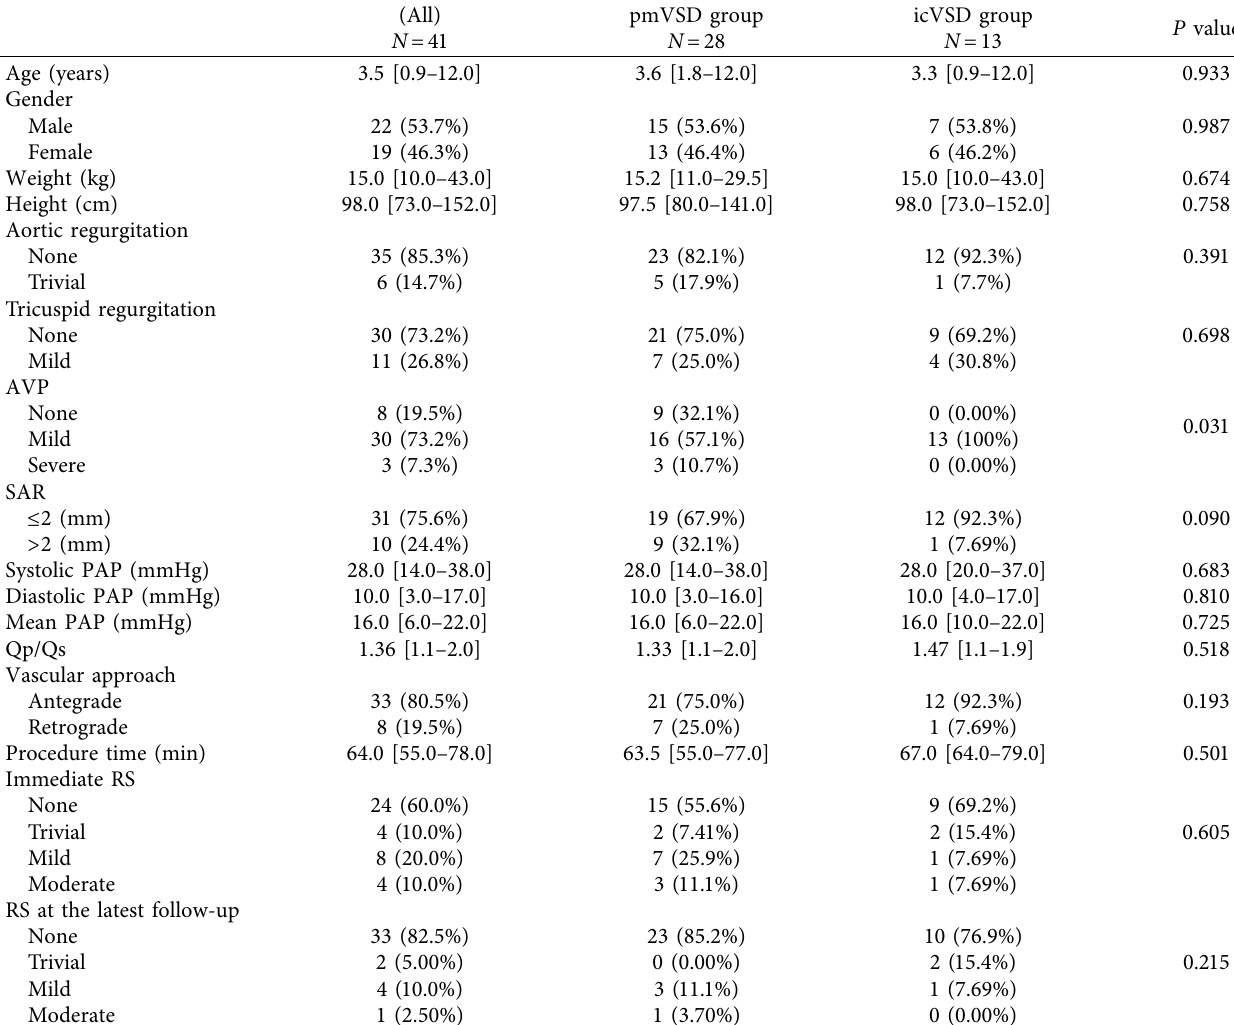
Table 1: Baseline and procedural characteristics of the study